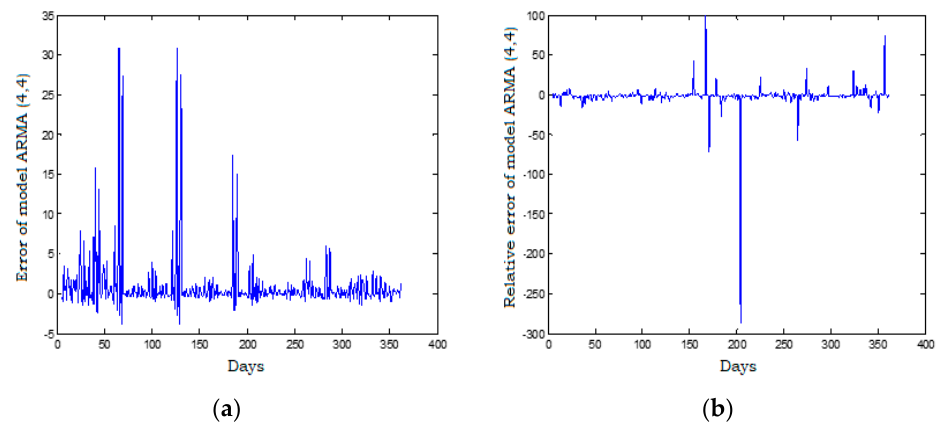
Figure 16. Solar radiation evolution prediction using the ARMA (4,4) model (daily radiation averages).